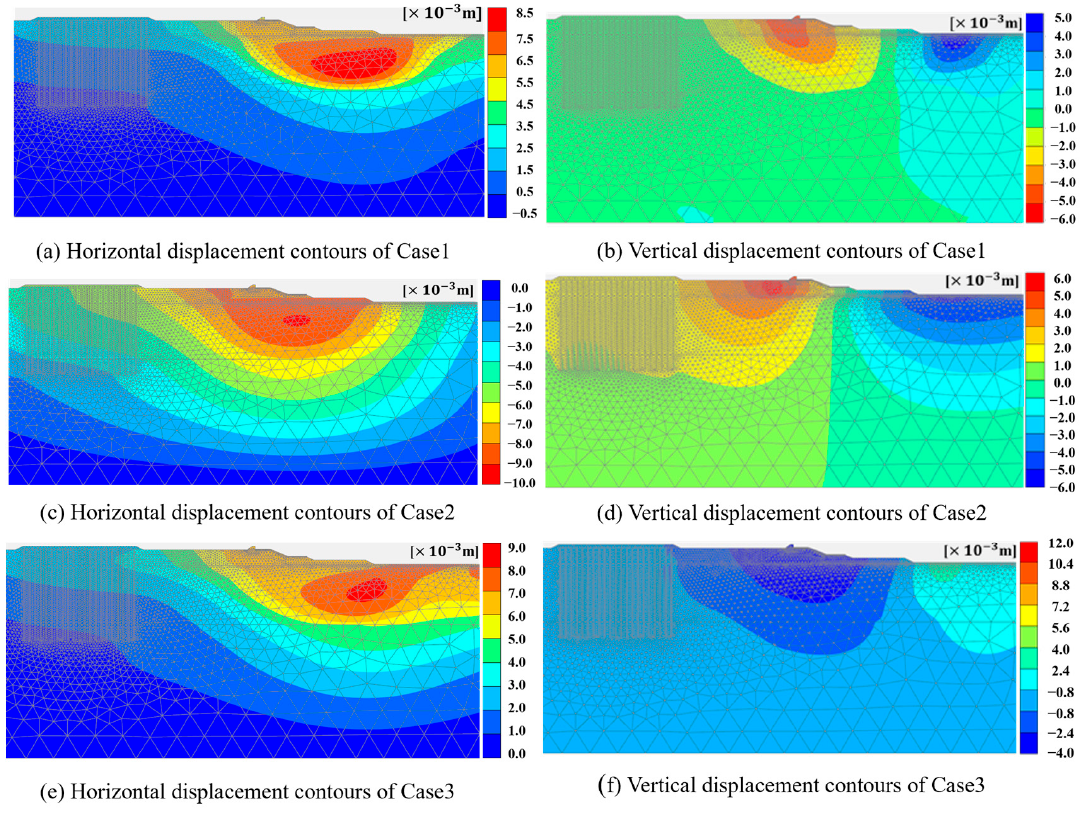
Figure 6. Contours of horizontal displacement and vertical displacement of foundation soil under three cases.